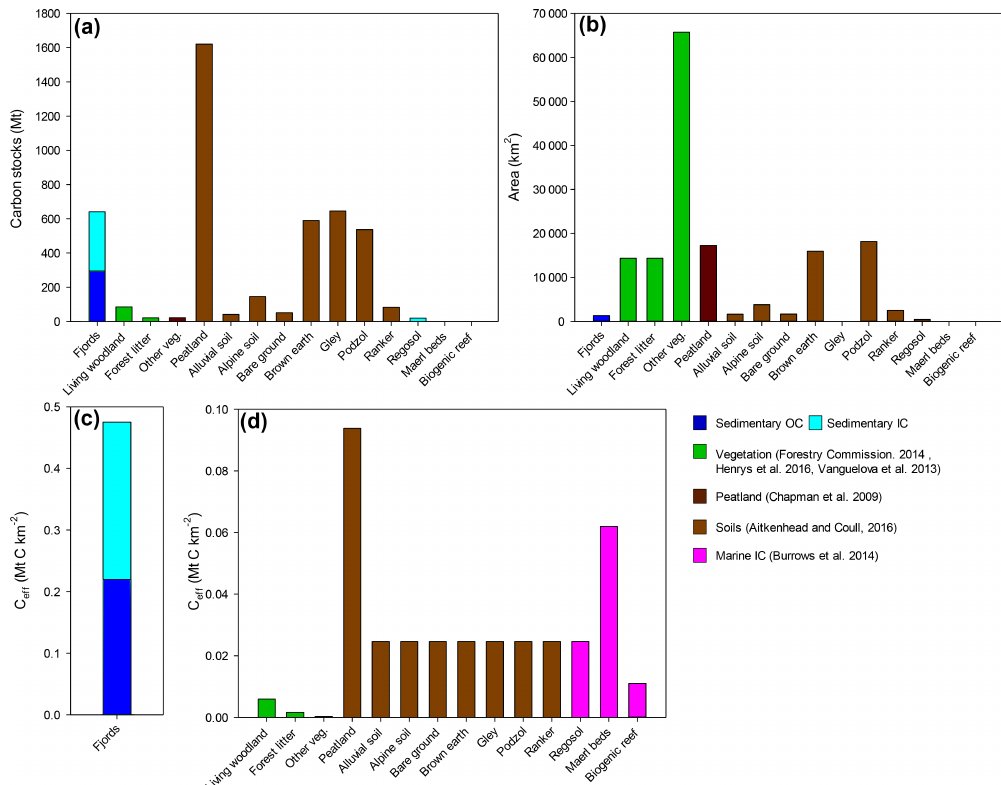
Figure 6. Comparison of Scotland’s national fjordic sedimentary C store and other national inventories of C. (a) Carbon stocks (Mt), (b) area of storage (km 2 ) and (c) effective carbon storage (MtCkm − 2 ) for the 111 fjords. (d) Effective carbon storage (MtCkm − 2 ) for the other national C